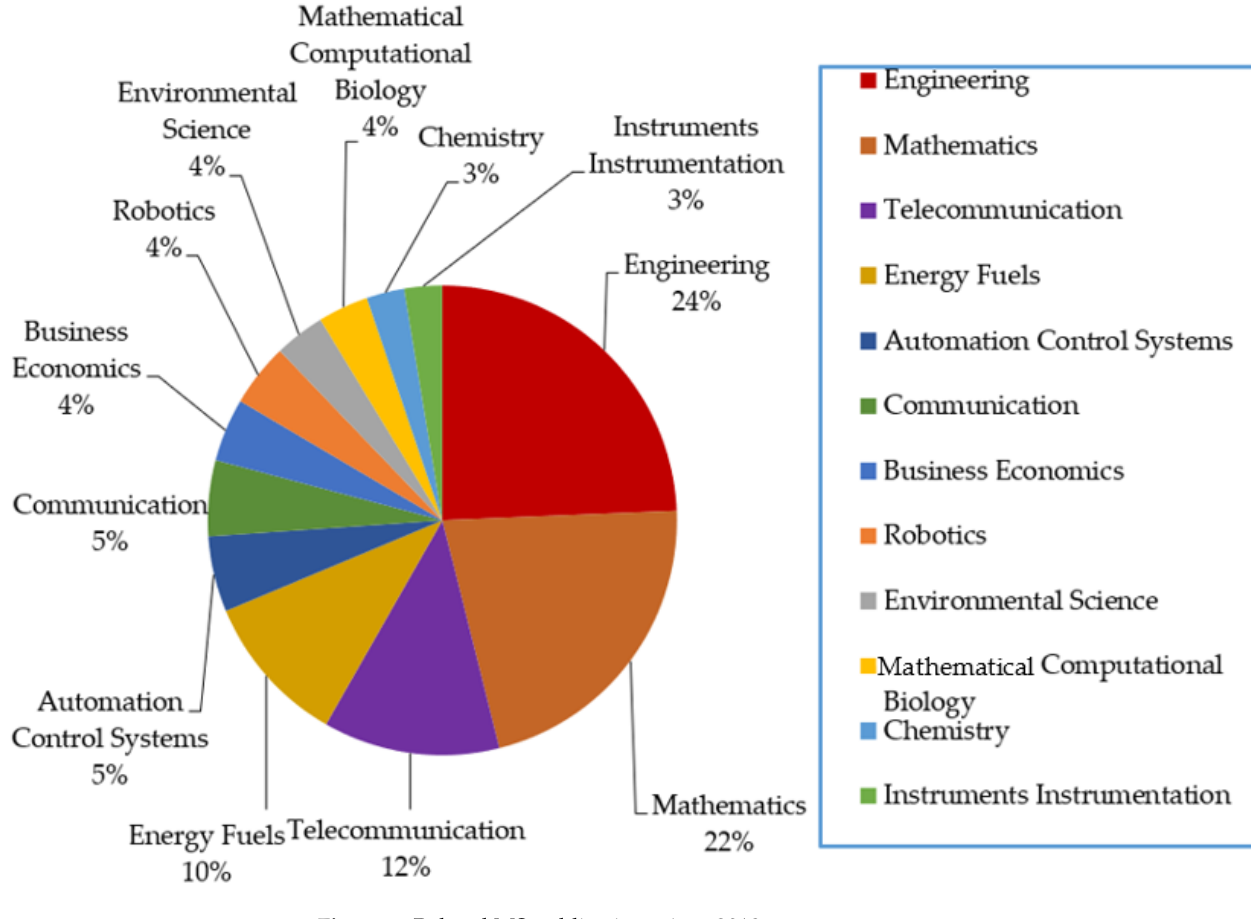
Figure 2. Related MS publications since 2018.